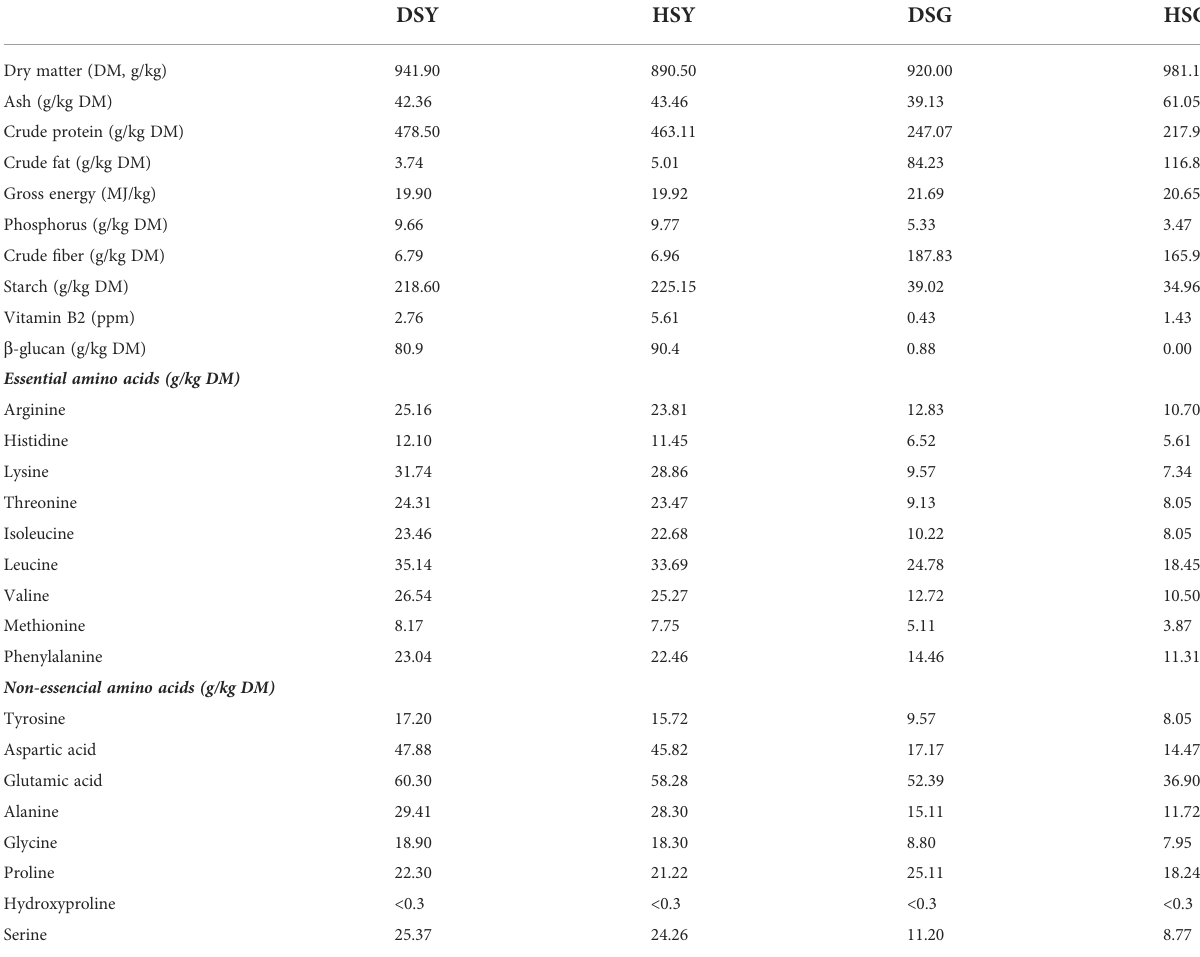
TABLE 2 Proximate composition and amino acid pro fi le of the ingredients derived from the brewery industry [spent yeast (SY) and spent grain (SG)] dried (D) and hydrolyzed (H), used in the formulation of the feed. DSY HSY DSG Dry matter (DM,